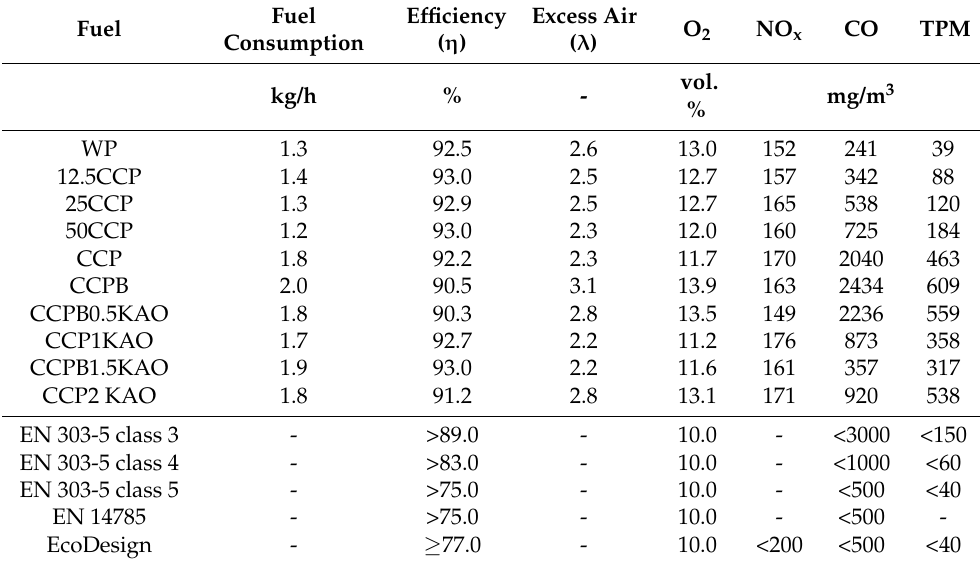
Table 3. Performance indicators and emissions (for list of fuel names and abbreviations see Table